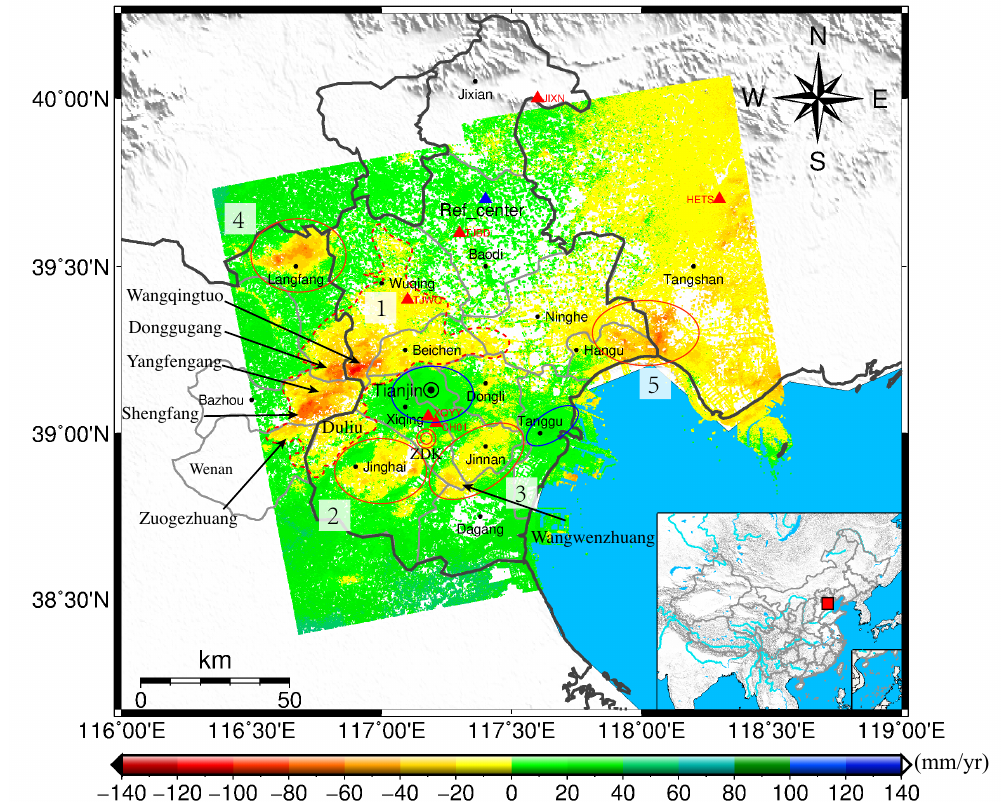
Figure 12. Linear deformation trend derived by PS technique along the LOS direction of ascending pairs, blue triangle denotes the reference point, red triangles denote the GPS stations and the double circles denote the well station ZDK. Each administrative region and severely deformation areas are marked in black font. 1–5 represent five major subsidence areas which enclosed by red lines. Two surface uplifting areas are also represent by blue